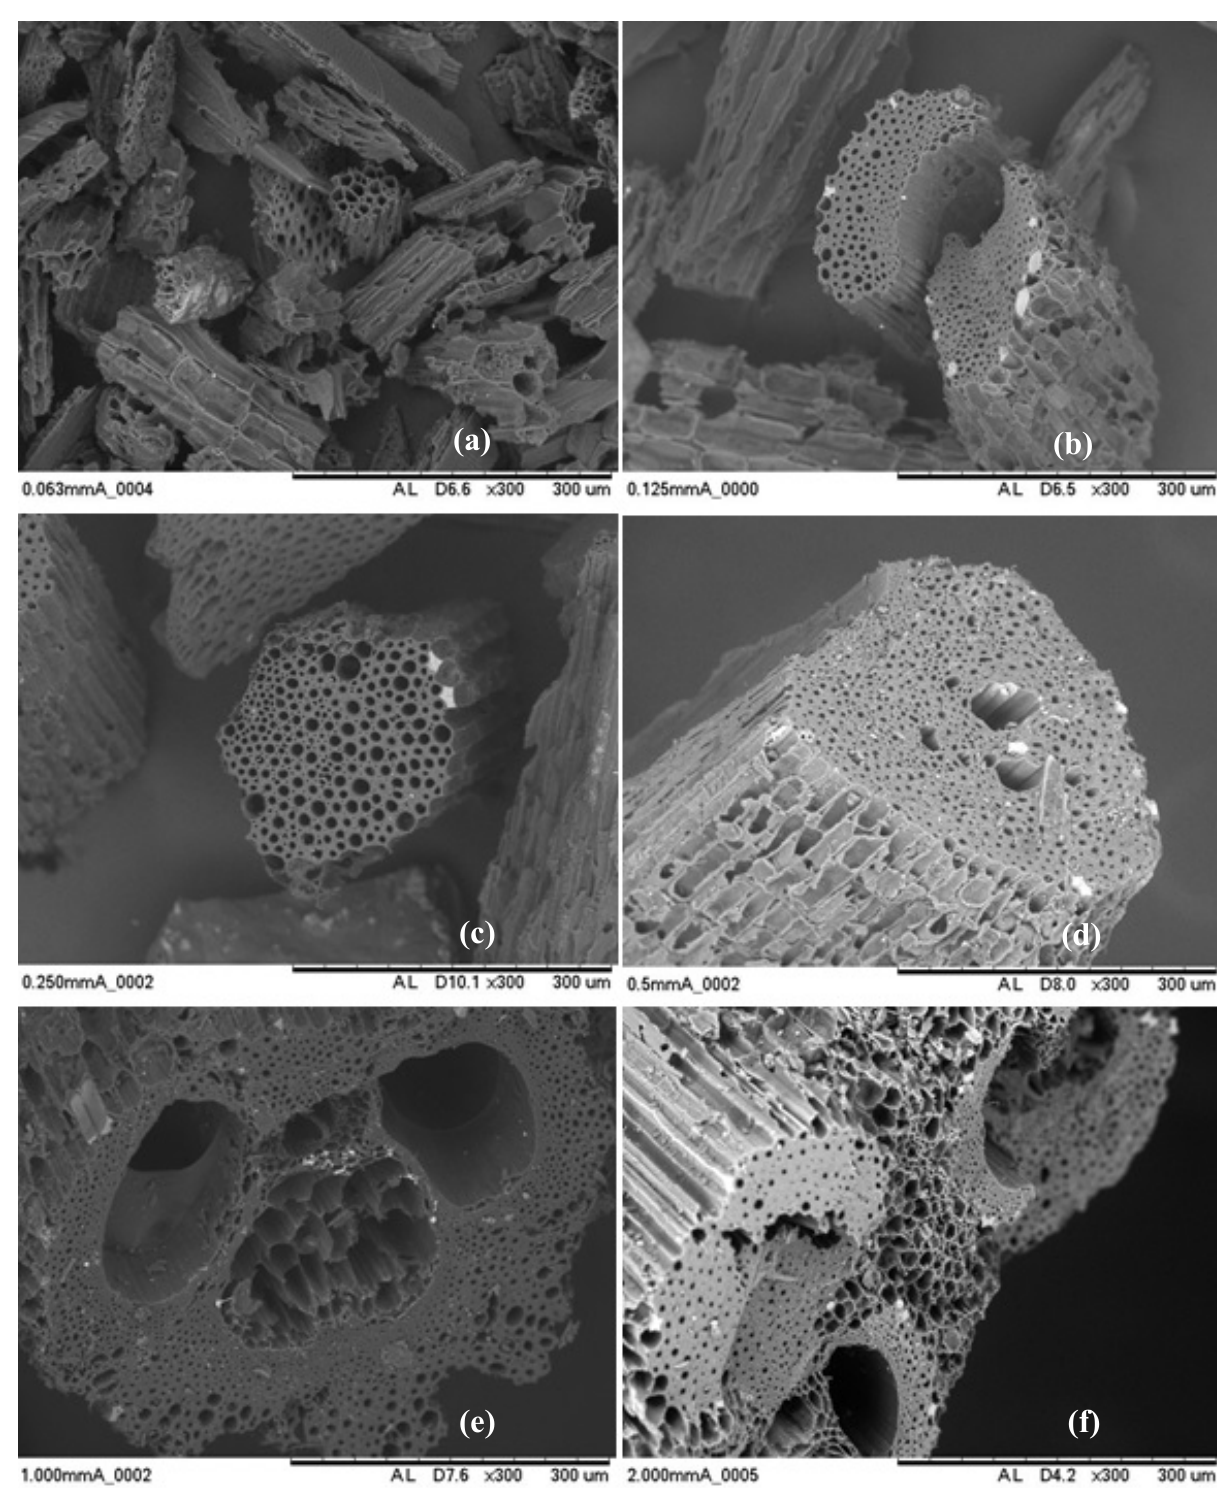
Figure 4. Scanning electron microscope (SEM) analysis (bar 300 µm × 300 magnification) to characterize porosity composition of the different bamboo biochar particle sizes of ( a ) 0.063 mm, ( b ) 0.125 mm, ( c ) 0.250 mm, ( d ) 0.500 mm, ( e ) 1.0 mm, and ( f ) >2 mm.